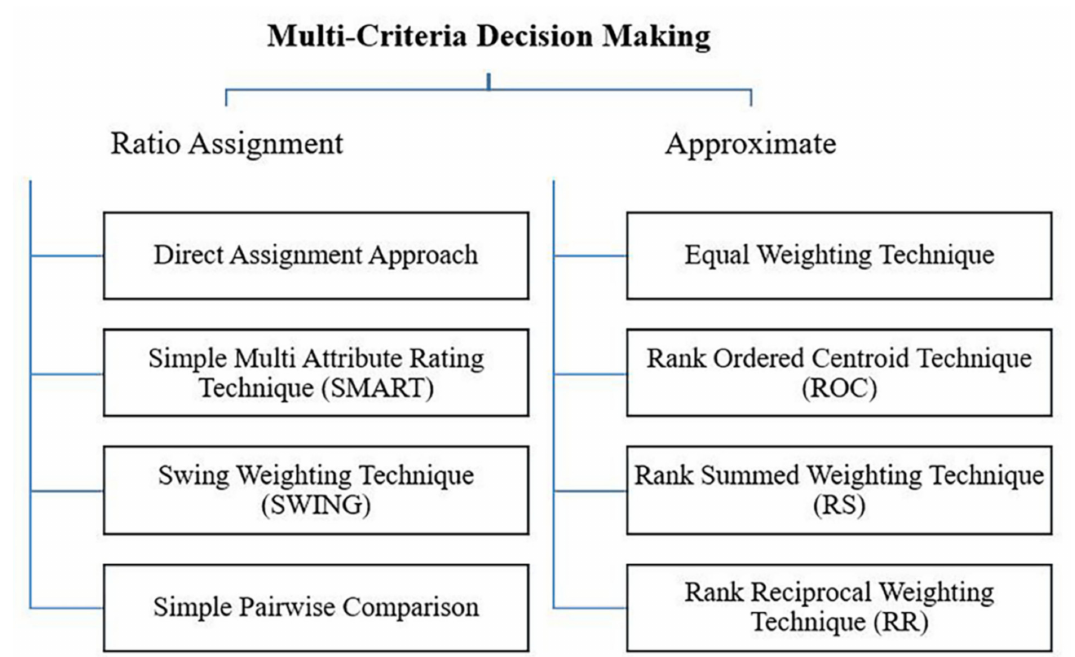
Figure 1. Taxonomy of Multi-Criteria Decision Analysis